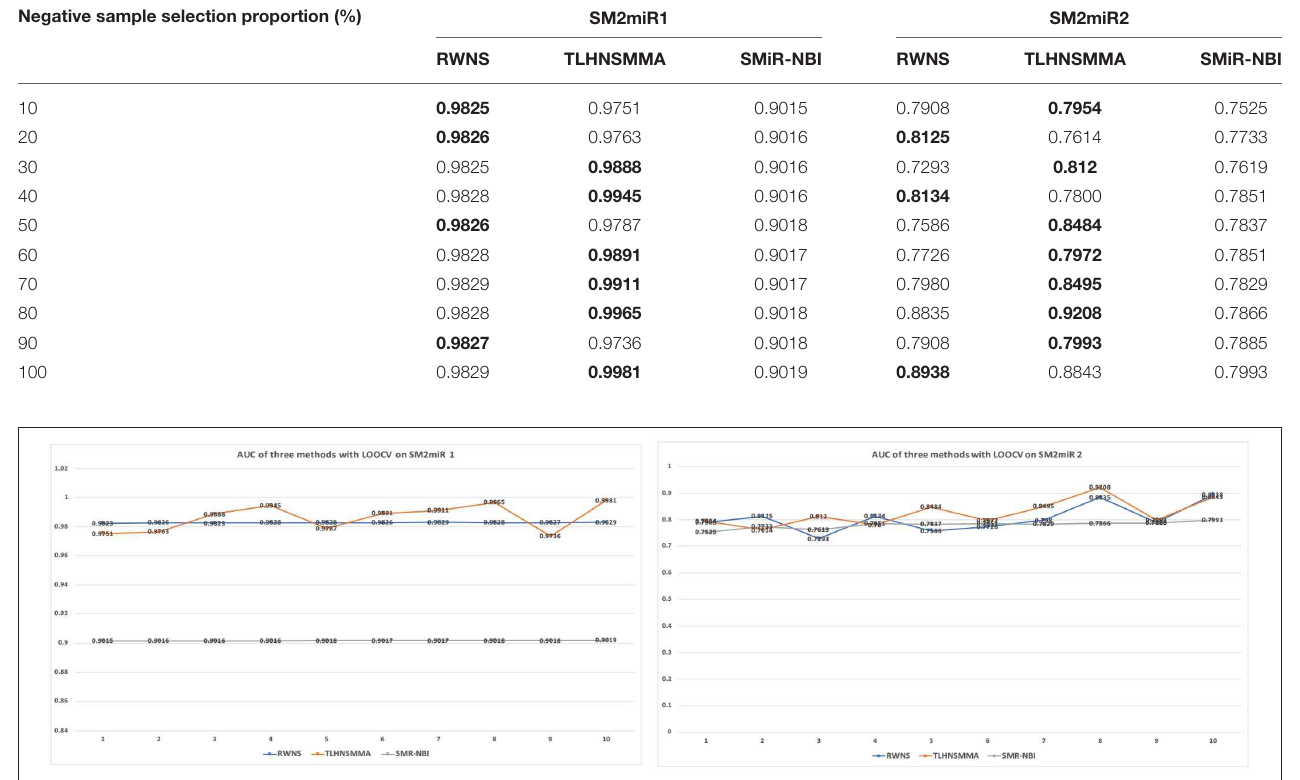
TABLE 2 | The performance comparison of RWNS, TLHNSMMA, and SMiR-NBI under LOOCV on SM2miR1 and SM2miR2. Negative sample selection proportion (%)